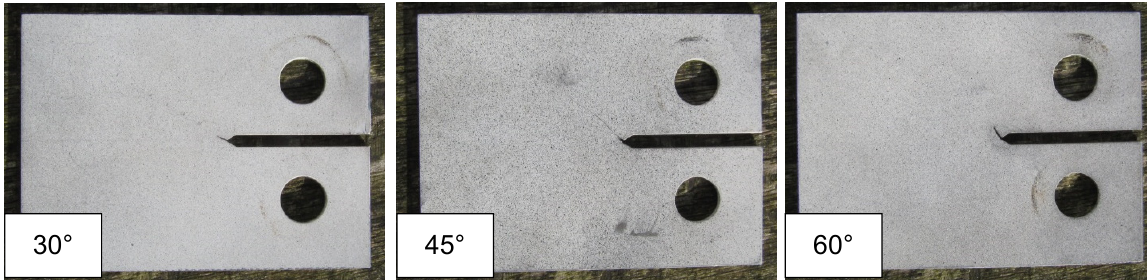
Figure 1: Typical aluminium CT specimens used in this work. In these specimens the initial inclined slit has been extended by fatigue crack growth.